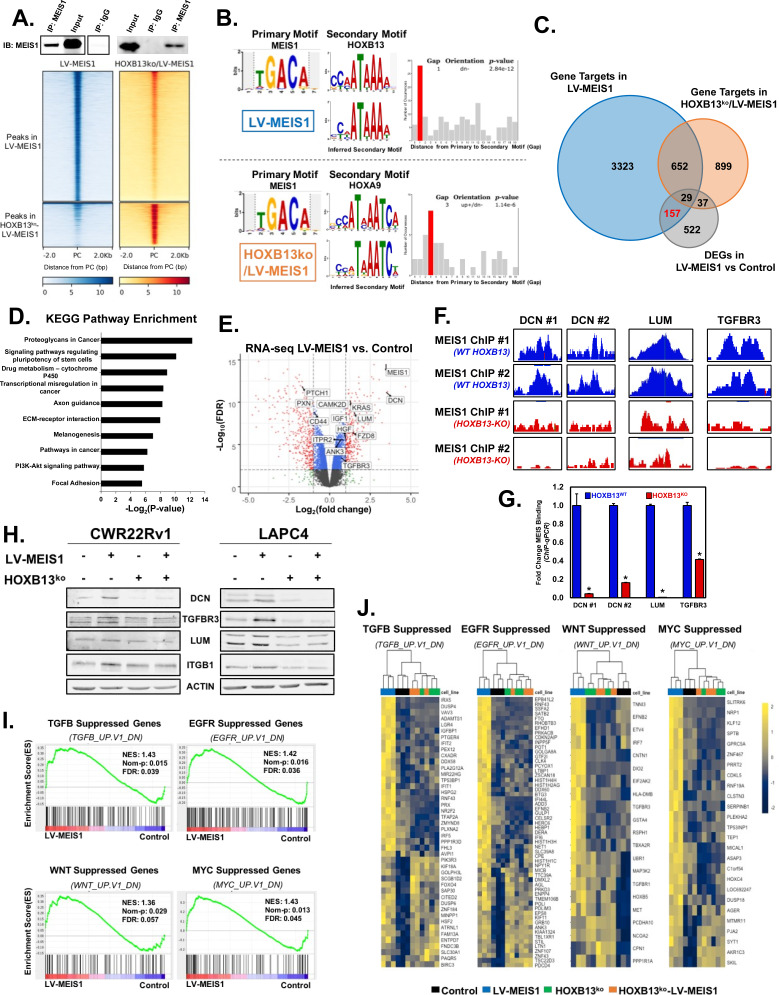
Integration of ChIP-seq and RNA-seq analyses reveals MEIS1-mediated, HOXB13-dependent, direct regulation of proteoglycans including Decorin (DCN).(A) Western blot confirmation of pull-down of MEIS1 from chromatin in CWR22Rv1 LV-MEIS1 and HOXB13ko-LV-MEIS1 cell lines (Top) and heatmap of read density profiles from MEIS1 ChIP-seq for ±2 kb of the peak center (PC) called by MACS2 (Bottom). Graphs are separated vertically into peaks called from LV-MEIS1 samples vs. input DNA (LV-MEIS1 peaks), where both MEIS1 and HOXB13 are expressed, and peaks called from HOXB13ko-LV-MEIS1 samples vs. input DNA (HOXB13ko-LV-MEIS1 peaks), where only MEIS1 is present and HOXB13 has been knocked-out. (B) Spaced Motif (SpaMo) analysis querying MEIS1 as the primary motif demonstrates an inferred secondary motif matching HOXB13 has a conserved spacing from the MEIS1 motif that is most significant at 1 bp away, downstream and on the opposite DNA strand in MEIS1 peaks from LV-MEIS1 ChIP-seq (top). In MEIS1 peaks from HOXB13ko-LV-MEIS1 ChIP-seq, SpaMo analysis identifies an inferred motif matching HOXA9 as the only HOX motif with a significant conservation of spacing with the MEIS1 motif and is most significant at 3 bp away on either DNA strand regardless of up or downstream (bottom). (C) Venn diagram demonstrating the number of genes with differential expression (fold-change >±1.5, FDR < 0.05) in CWR22Rv1-LV-MEIS1 vs. CWR22Rv1-Control cells from RNA-seq of these lines (gray), overlapped with the number of genes that MEIS1 peaks were annotated to using HOMER in either LV-MEIS1 (blue) or HOXB13ko-LV-MEIS1 (orange) ChIP-seq. The 157 genes (red) represent prioritized MEIS effector genes, since they are bound and differentially expressed only when HOXB13 is present. (D) Top 10 significantly enriched pathways from KEGG pathway enrichment analysis using the list of 157 genes identified in (C). (E) Volcano plot of gene expression Log2(fold-change) vs. significance (FDR) in CWR22Rv1 LV-MEIS1 vs. control cells. Dashed lines indicate thresholds for fold-change >2 or<2 and for FDR value <0.01. Highlighted gene symbols indicate genes that: 1) are within the ‘proteoglycans in cancer’ pathway curated by KEGG, 2) are annotated as targets in the MEIS1 ChIP-seq from LV-MEIS1 cells, and 3) have significant differential expression in LV-MEIS1 vs. control RNA-seq (fold-change >±1.5, FDR < 0.05). Gray dots indicate genes with no significant differential expression; green dots indicate genes with fold-change >±2 but FDR > 0.01; blue dots indicate genes with FDR < 0.01 but fold-change <±2; and red dots indicate genes with both FDR < 0.01 and fold-change >±2. (F) Integrated Genome Browser tracks of MEIS1 ChIP in the presence (WT-HOXB13, blue) and absence of HOXB13 (HOXB13-KO, red) at the DCN (2 regions, DCN #1 and DCN #2), LUM, and TFGBR3 loci. (G) ChIP-qPCR of MEIS1 binding using site-specific genomic primers against DCN, LUM, and TGFBR3 loci. MEIS1 binding is significantly diminished when HOXB13 is deleted (HOXB13KO; * indicates p<0.05). (H) Western blot analysis of key genes with significant differential expression in RNA-seq between CWR22Rv1-LV-MEIS1 and control. DCN, TGFBR3, and LUM are direct targets of MEIS1 from ChIP-seq data and ITGB1 is a downstream target of LUM. (I) Gene set enrichment analysis (GSEA) from RNA-seq between CWR22Rv1-LV-MEIS1 and control cells on the oncogenic signatures collection from MSigDB. Enrichment is observed in CWR22Rv-LV-MEIS1 cells for genes known to be suppressed by: active TGFβ signaling (TGFB_UP.V1_DN, NES: 1.43, FDR: 0.039), active EGFR signaling (EGFR_UP.V1_DN, NES: 1.42, FDR: 0.036), active WNT signaling (WNT_UP.V1_DN, NES:1.36, FDR 0.057), and active c-MYC signaling (MYC_UP.V1_DN, NES: 1.43, FDR: 0.045). (J) Heatmaps of expression and unsupervised clustering of RNA-seq from CWR22Rv1 control (purple), LV-MEIS1 (blue), HOXB13ko (green), and HOXB13ko-LV-MEIS1 (orange) cells for all genes in the leading edge of enrichment for each gene set in (G). See also Figure 5—figure supplement 1 and Supplementary files 1–6.